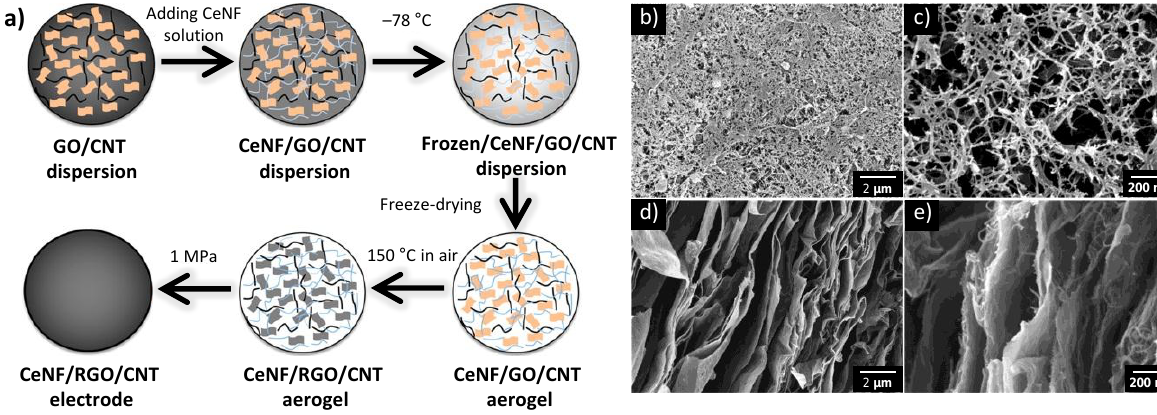
Figure 6. ( a ) Schematic of the fabrication process of a CeNF/RGO/CNT aerogel electrode. SEM images of compressed CeNF/RGO/CNT hybrid aerogel films, ( b and c ) bottom surface of the aerogel film, and ( d and e ) cross section of the aerogel film. With permission from [46];